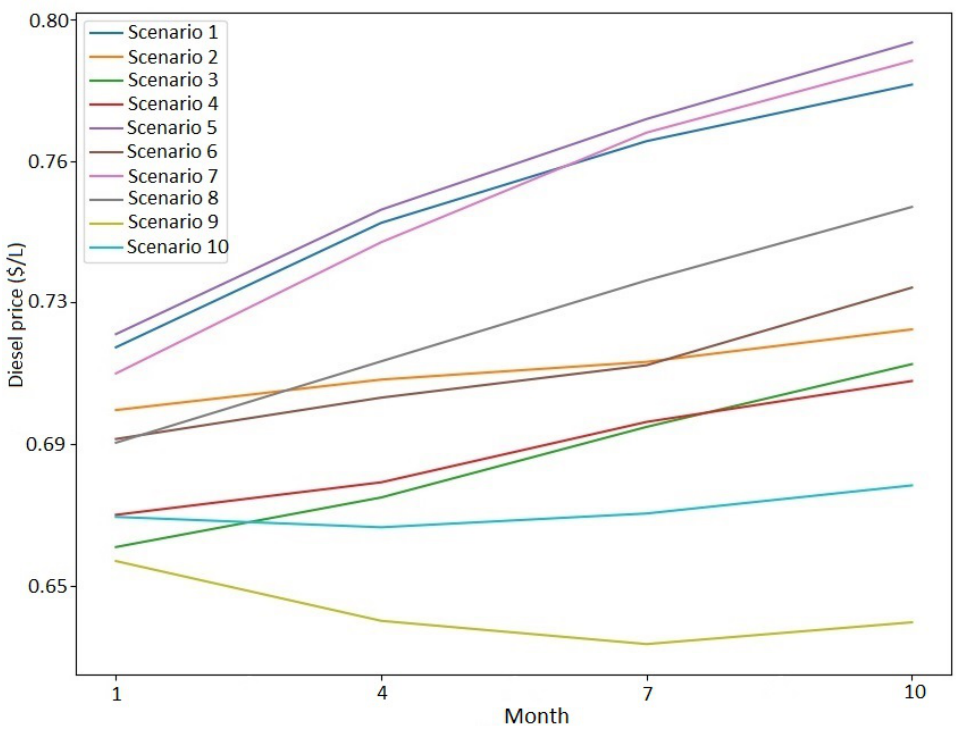
Figure 3. Diesel price scenarios.